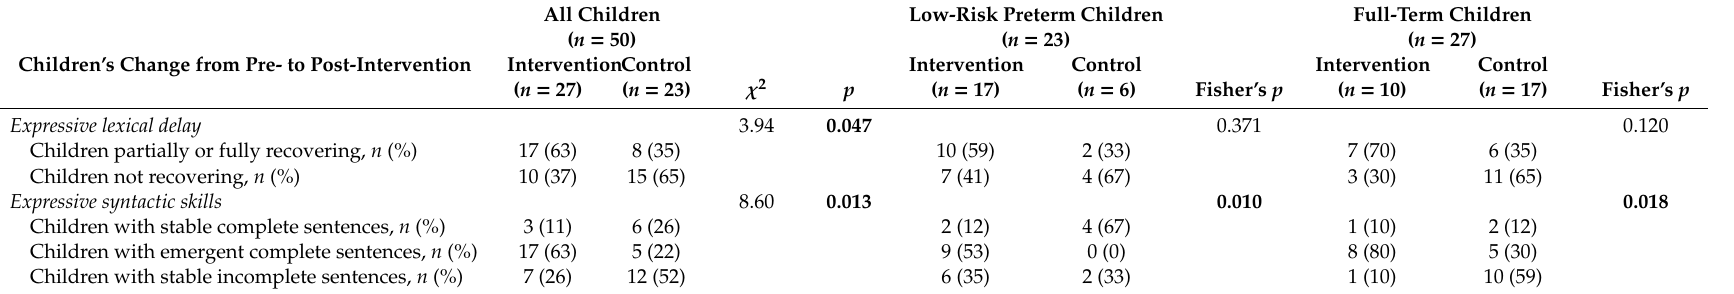
Table 4. Children’s change from pre- to post-intervention in expressive lexical delay and expressive syntactic